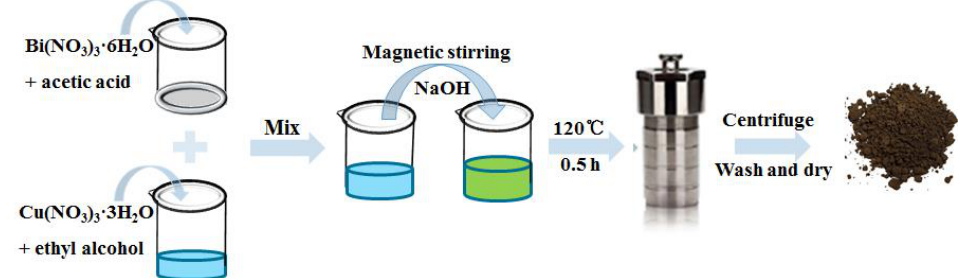
Figure 1. The preparation of CuBi 2 O 4 via the hydrothermal treatment.